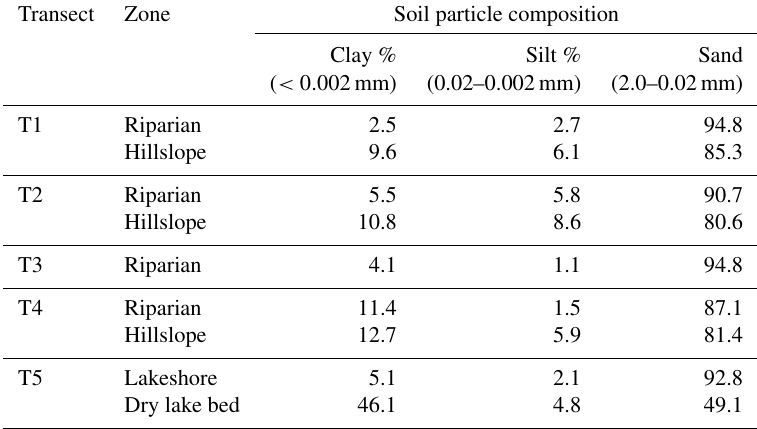
Table 2. Soil particle composition of soils at various sites within each